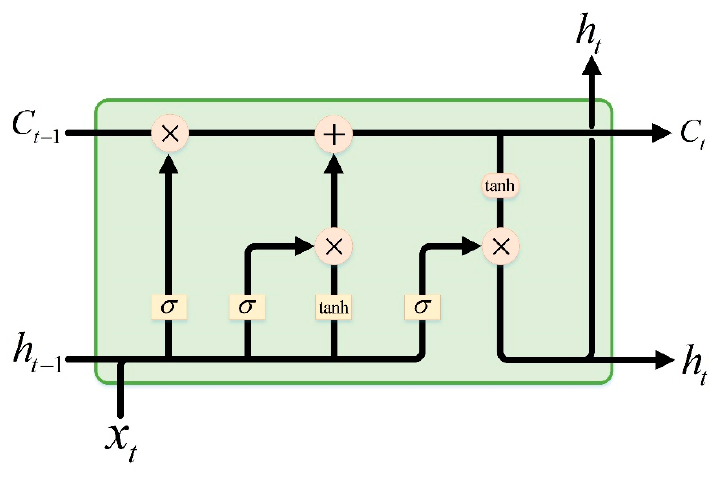
Figure 4. The structure of the long short-term memory (LSTM) network